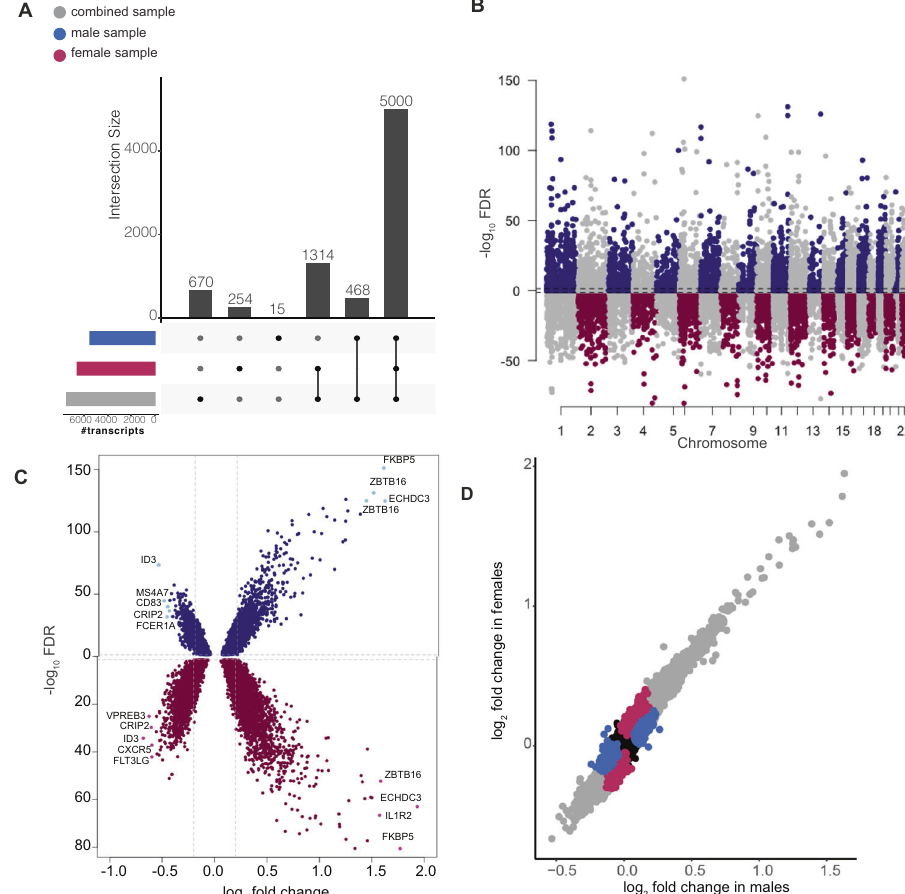
Fig. 2 Differential GR-response gene expression analysis results. Differential GR-response gene expression analysis (GR-DEA): A Upset plot displaying the overlapping signi fi cant transcripts identi fi ed in combined and sex-strati fi ed GR-DEA. The majority of transcripts were found in both the combined and strati fi ed analyses independently. B Miami plot of results across 11,994 autosomal transcripts. Dashed lines indicate signi fi cance cut-off at an FDR of 5%. 6,568 GR-DE transcripts were signi fi cantly differentially regulated in females ( n = 93 individuals; bottom panel) and 5483 GR-DE transcripts in males ( n = 196 individuals; top panel). C Volcano plot of log2 fold change ( x- axis) by − log 10 FDR . Upper panel showing male GR-DE transcripts at an FDR of 0.05 with FCs ranging from 0.68 to 3.06. Lower panel showing female GR-DE transcripts with FCs ranging from 0.62 to 3.82. D Scatterplot showing the difference in gene expression between post dexamethasone and baseline for males ( y -axis) and females ( x -axis) colored by identi fi cation in combined analysis ( n = 5000 transcripts), females ( n = 1568), males ( n = 483), and neither females or males ( n = 4943). Signi fi cant results, whether supported in the combined analysis or limited to sex-strati fi ed analyses, are mainly limited to the upper right and lower left quadrants, supporting consistent effect directions between males and